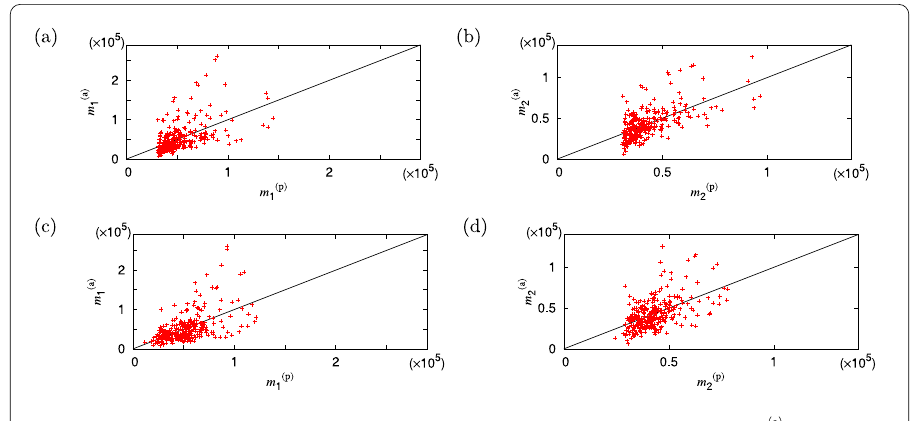
Figure 9 Linearregressionanalysisoftheridershipandaccessibilitymodels . Actual population m ( a ) τ versus predicted population m ( p ) τ from the ridership model is plotted for ( a ) the daytime ( τ = 1) and ( b ) the evening ( τ = 2). In ( c ) and ( d ), actual population versus predicted population from the exponential accessibility is presented for the daytime and the evening, respectively. The coefficient of determination takes the values R 2 = 0.29,0.38,0.32,and 0.27, respectively